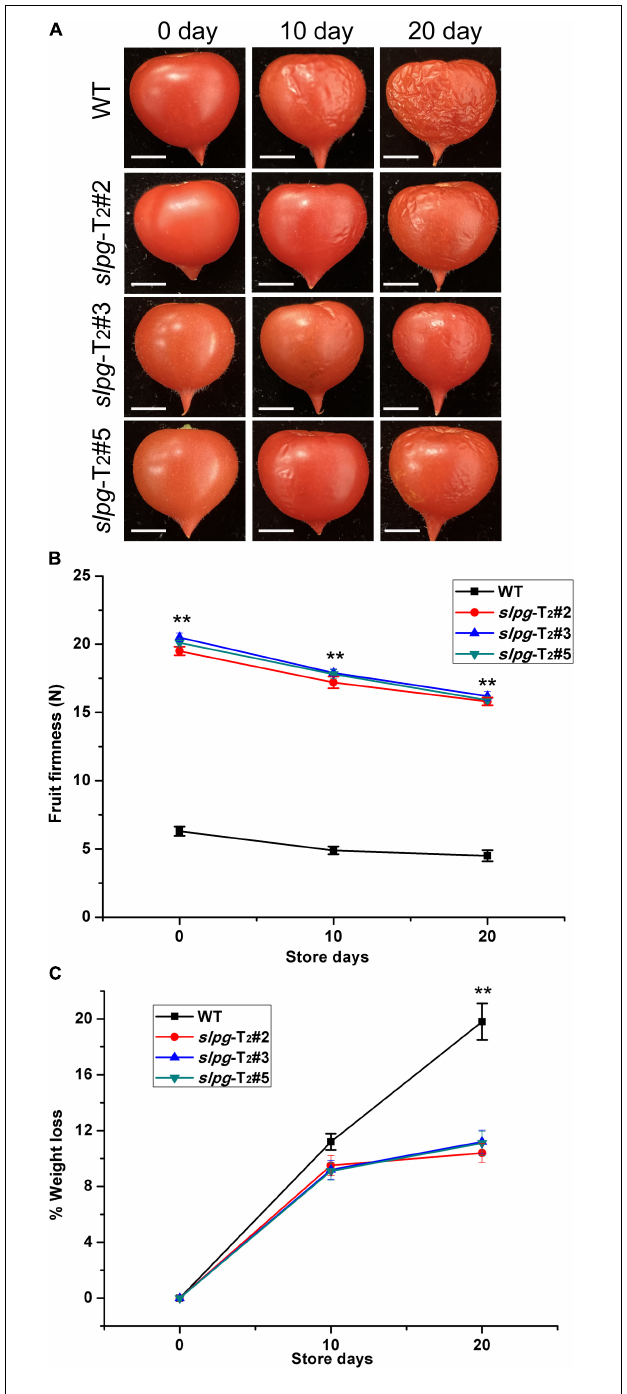
FIGURE 3 | Three slpg mutants ( slpg -T 2 #2, slpg -T 2 #3, and slpg -T 2 #5) show extended softening time. (A) RR fruit from three slpg mutants and WT plants after storage at room temperature for 0, 10, and 20 days. Scale bar, 0.5 cm. (B) Change of fruit firmness in three slpg mutants and WT